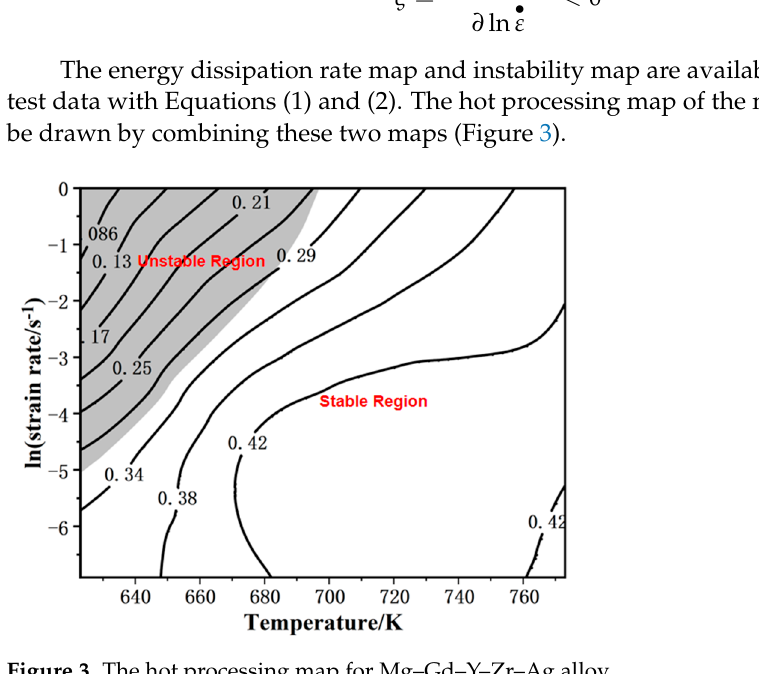
Figure 2. The fl ow stress curves under di ff erent test conditions. ( a ) 0.001s − 1 , ( b ) 0.01s − 1 , ( c ) 0.1s − 1 , ( d ) 1s − 1 .